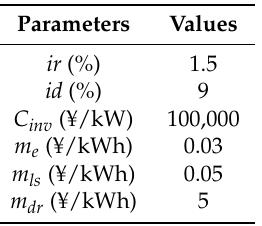
Table 3. Economic rated parameters.